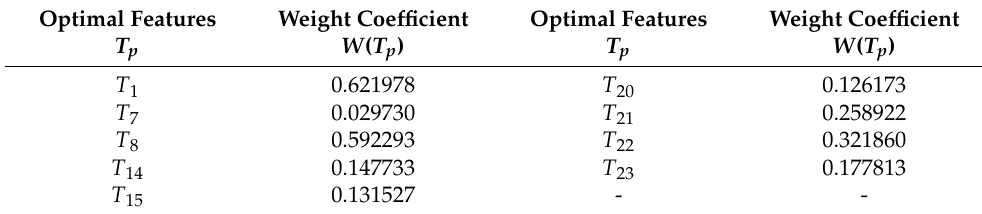
Table 3. Weight coefficient of the optimal features.